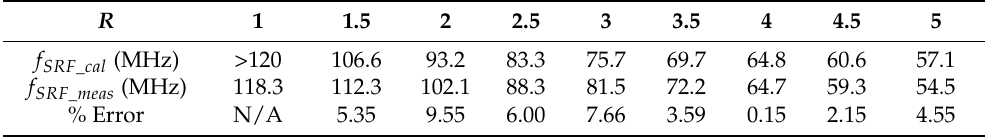
Table 11. Self-resonance frequency of elliptical planar inductors for varying major-to-minor ratios when trace separation ( S ) and trace width ( W ) were kept constant at 300 µ